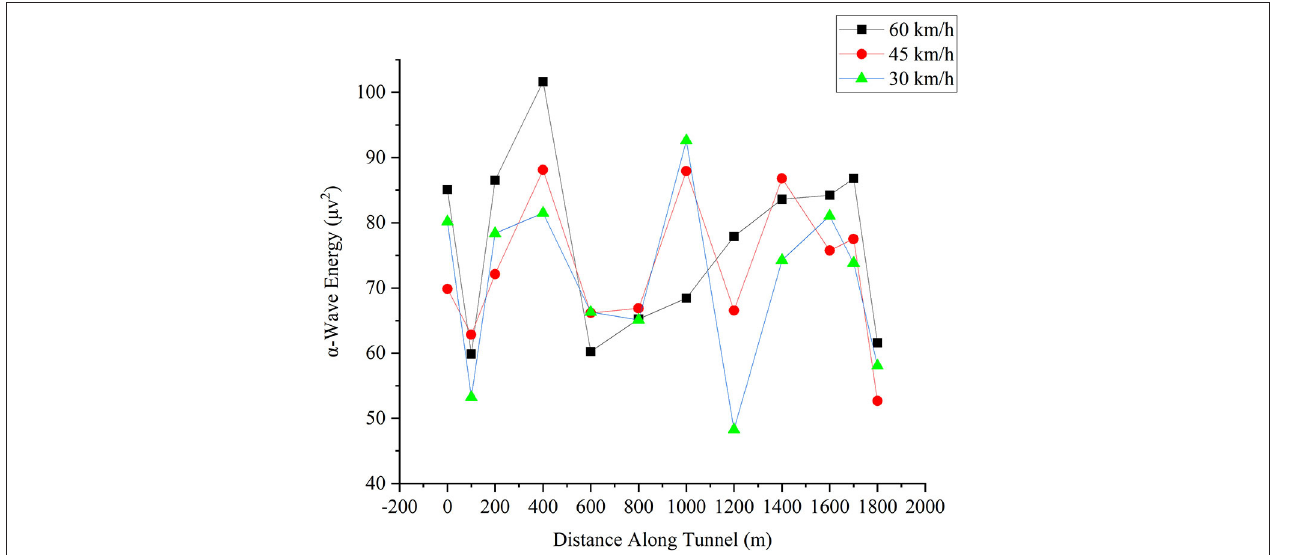
FIGURE 9 | Change in the wave ratio in the frontal lobe for different driving